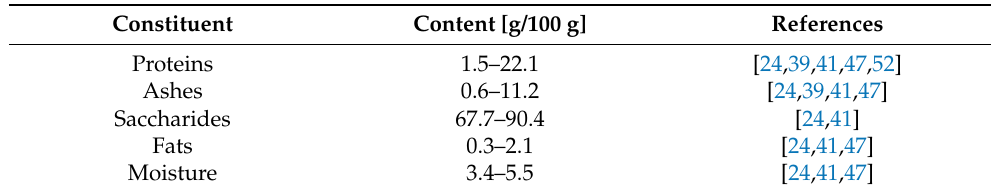
Table 1. Chemical composition of flaxseed gum powder. Presented as the ranges of values reported in the literature (on wet matter